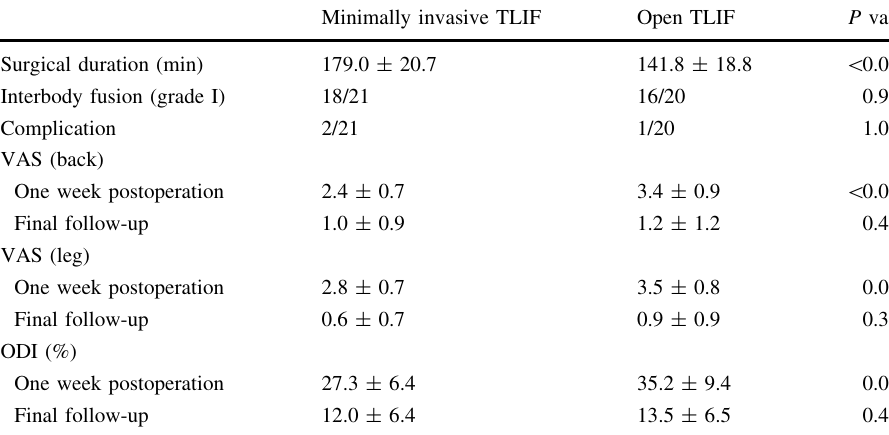
Minimally invasive